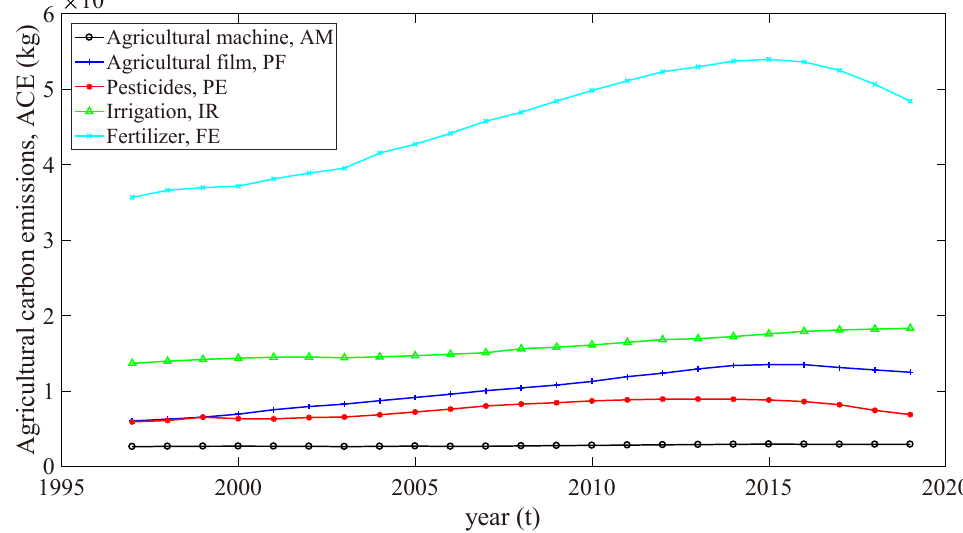
Figure 7. Historical trend of the agricultural carbon emission (ACE, kg) by carbon